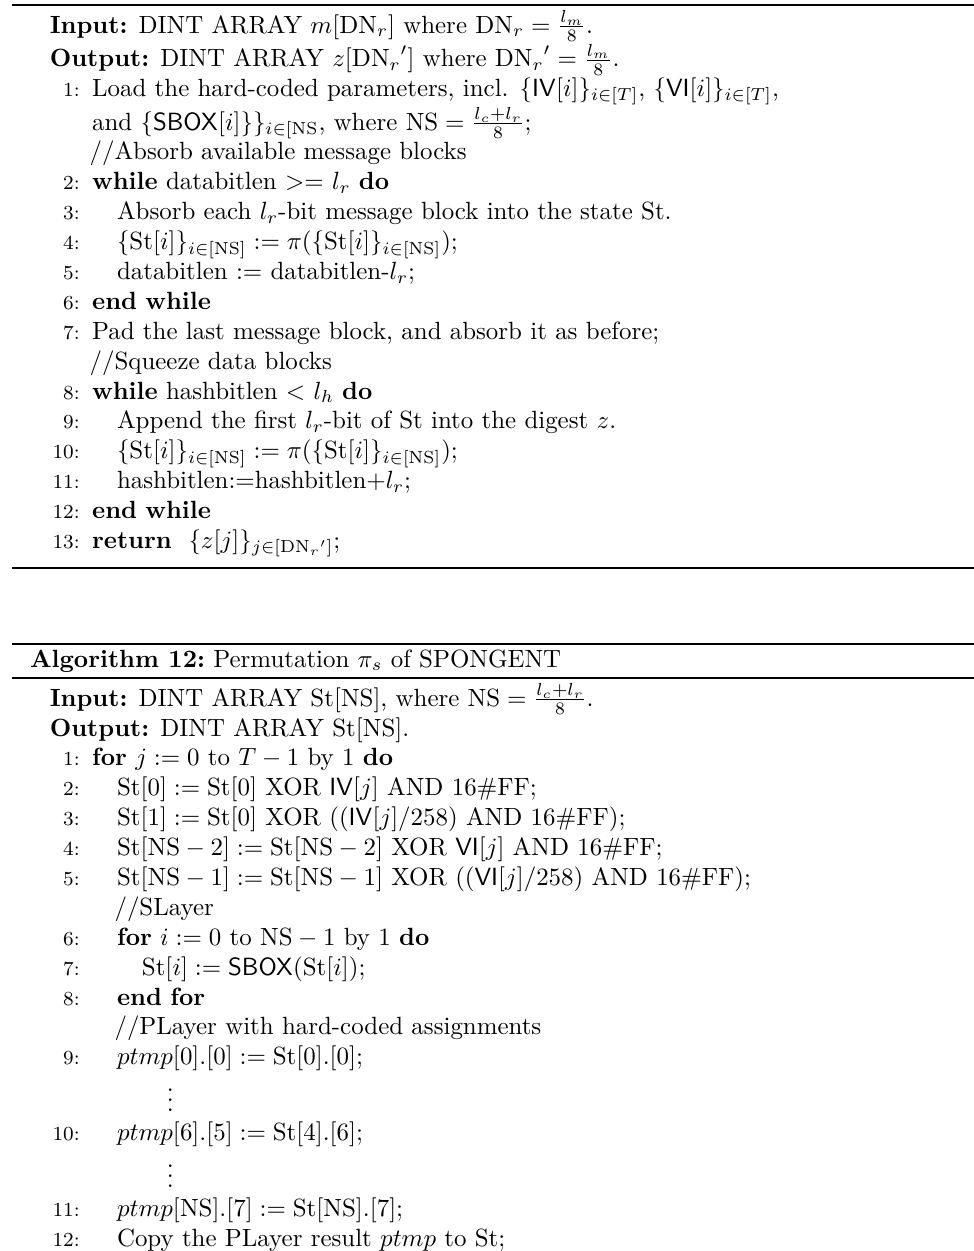
Algorithm 11: Evaluation of SPONGENT